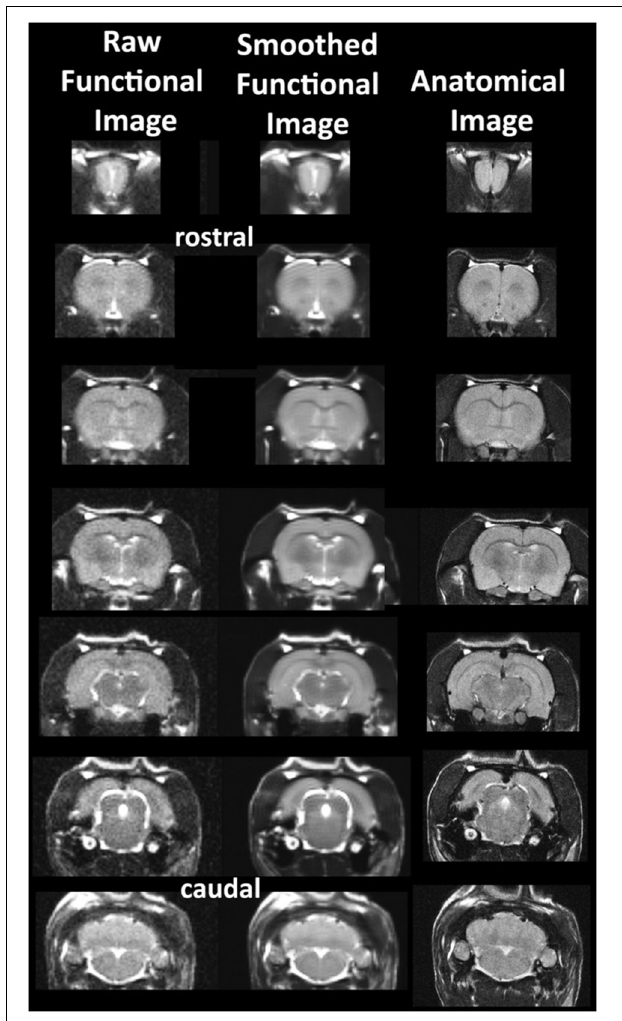
FIGURE 2 | Anatomical fidelity. Shown are examples of brain images collected during an awake imaging session in rats using a multi-slice spin echo, RARE (rapid acquisition with relaxation enhancement) pulse sequence. The anatomical images to the right are taken at the beginning of the scanning session. The column on the left shows the same images but collected for functional analysis using HASTE, a RARE pulse sequence modified for faster acquisition time. Whole brain acquisition time is approximately six sec with a spatial resolution of 312 µ m 2 . The images in the middle column have been smoothed during pre-processing. Note the anatomical fidelity between the functional images and their original anatomical image. The absence of any distortion is necessary when registering the data to an atlas. (Adapted with permission from Ferris et al.